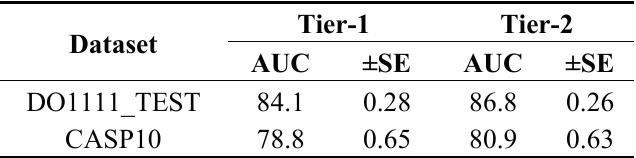
Table 3. Comparison of Tier 1 and Tier 2 predictions from WiDNdisorder on the DO1111_TEST and CASP10 datasets.